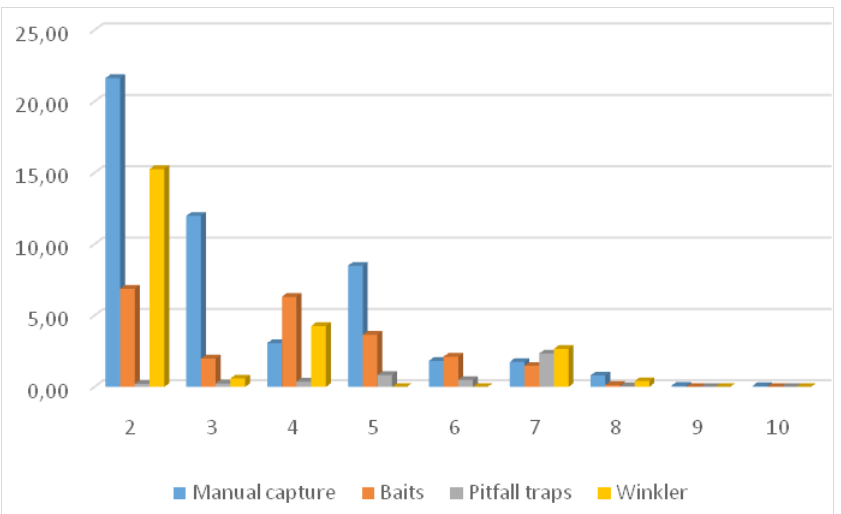
Fig 5 . Species frequencies’s representation according to the workers size harvested using the four sampling methods of the Guerrouche forest